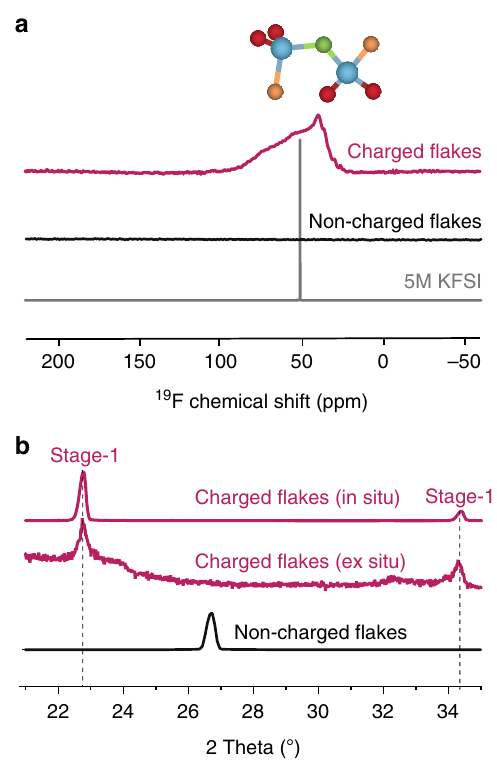
Fig. 4 19 F NMR and XRD characterization of graphite fl akes. a 19 F NMR spectra of charged and discharged graphite fl akes (washed in EC/DMC), non-charged graphite fl akes (reference), and 5 M KFSI/EC/DMC electrolyte. b XRD patterns of charged graphite, collected in situ and ex situ (i.e., after separation and washing of the graphite fl akes). For comparison, the pattern for pristine graphite is also